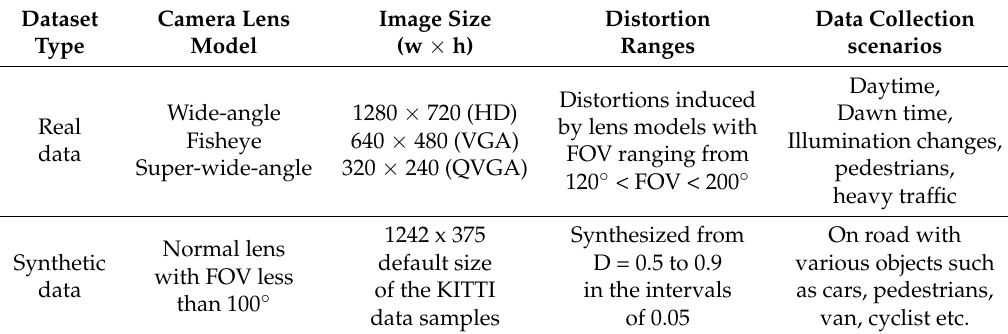
Table 3. Summary of datasets and their attributes used in the